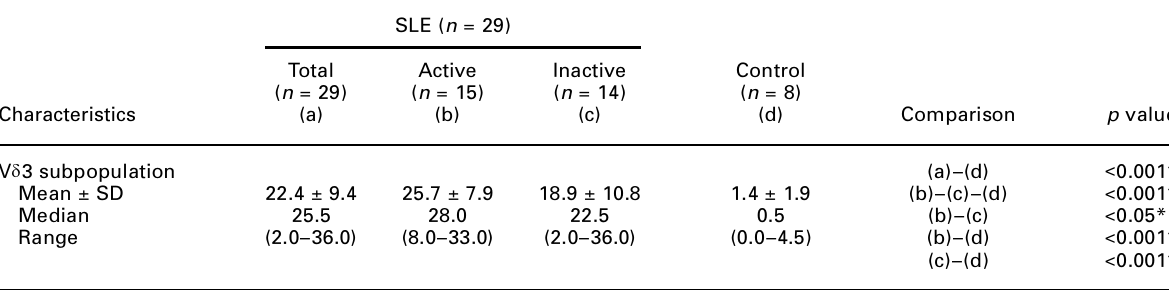
*Statistically significant